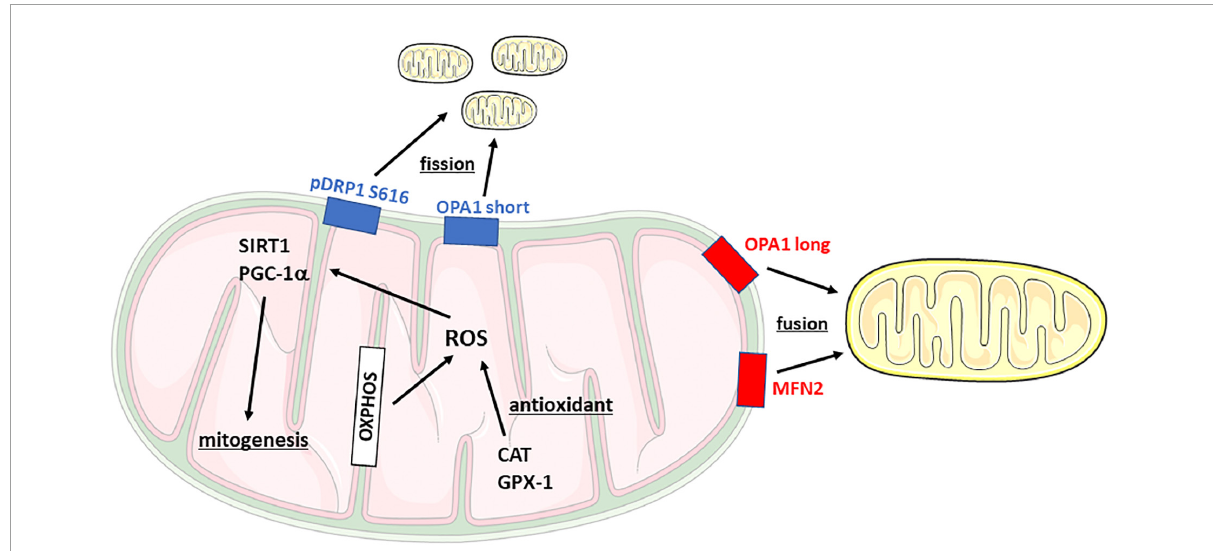
FIGURE1 Schematic representation of mitochondrial dynamics and main functions. CAT, Catalase; DRP1, Dynamin-related protein 1; Gpx-1, Glutathione peroxidase 1; MFN2, Mitofusin 2; OPA1, Optic Atrophy Protein 1; OXPHOS, oxidative phosphorylation complex; PGC-1 α , PPARG coactivator 1 α ; ROS, reactive oxygen species; SIRT1, Sirtuin